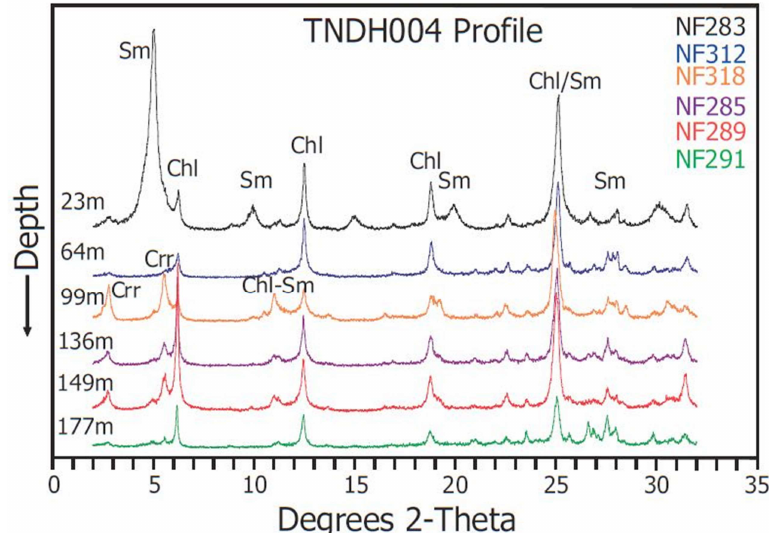
Figure 9. X-ray diffraction profiles showing the presence of various phyllosilicates including chlorite (Chl), smectite (Sm), corrensite (Crr), and illite (Ill), in samples NF283, NF312, NF318, NF285, NF289, and NF291 at depths of 23 m, 64 m, 99 m, 136 m, 149 m, and 177 m, respectively, in drill hole TNDH004 (Tuvatu North prospect).